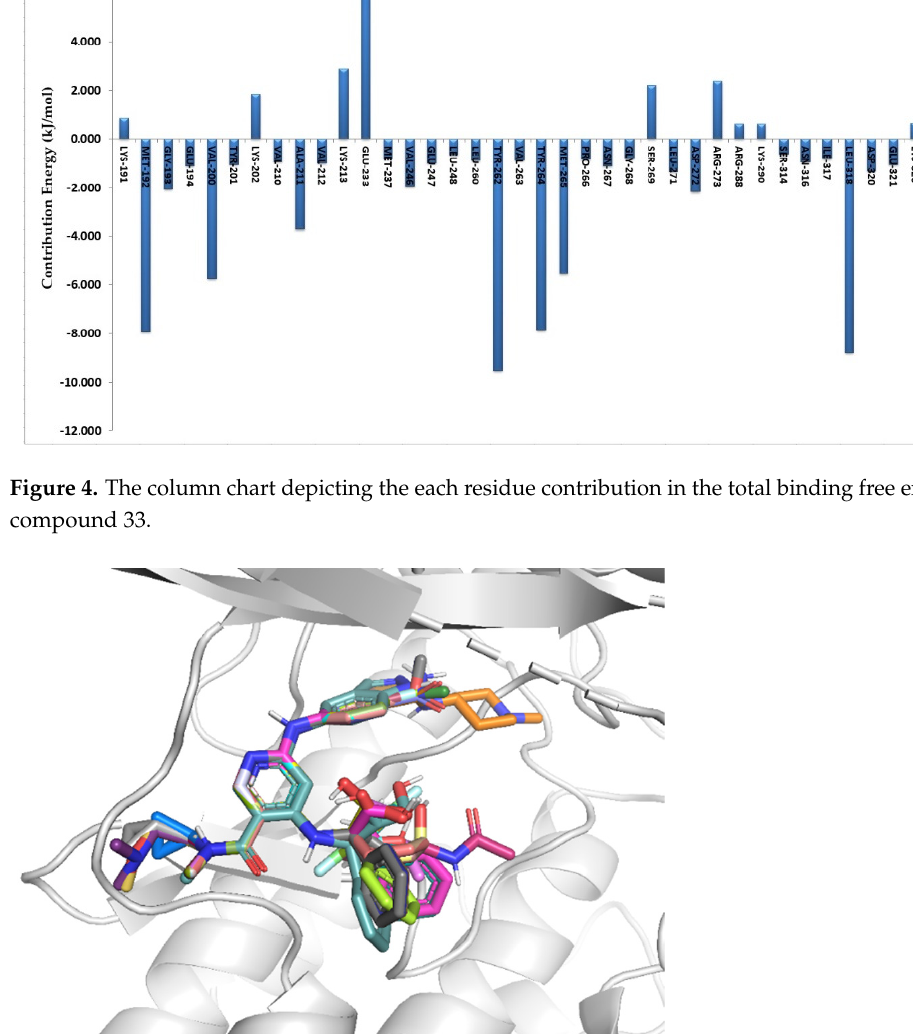
Figure 4. The column chart depicting the each residue contribution in the total binding free energy of compound 33.